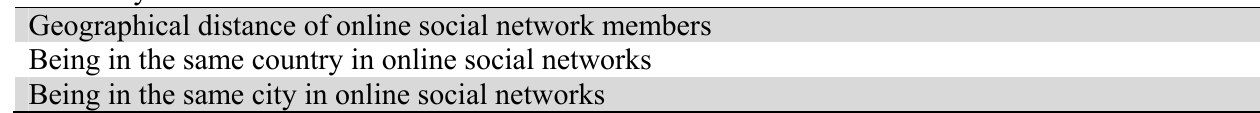
Proximity indexes of online social network